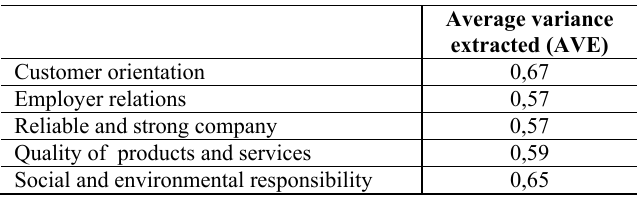
Table 6: Average variance extracted per